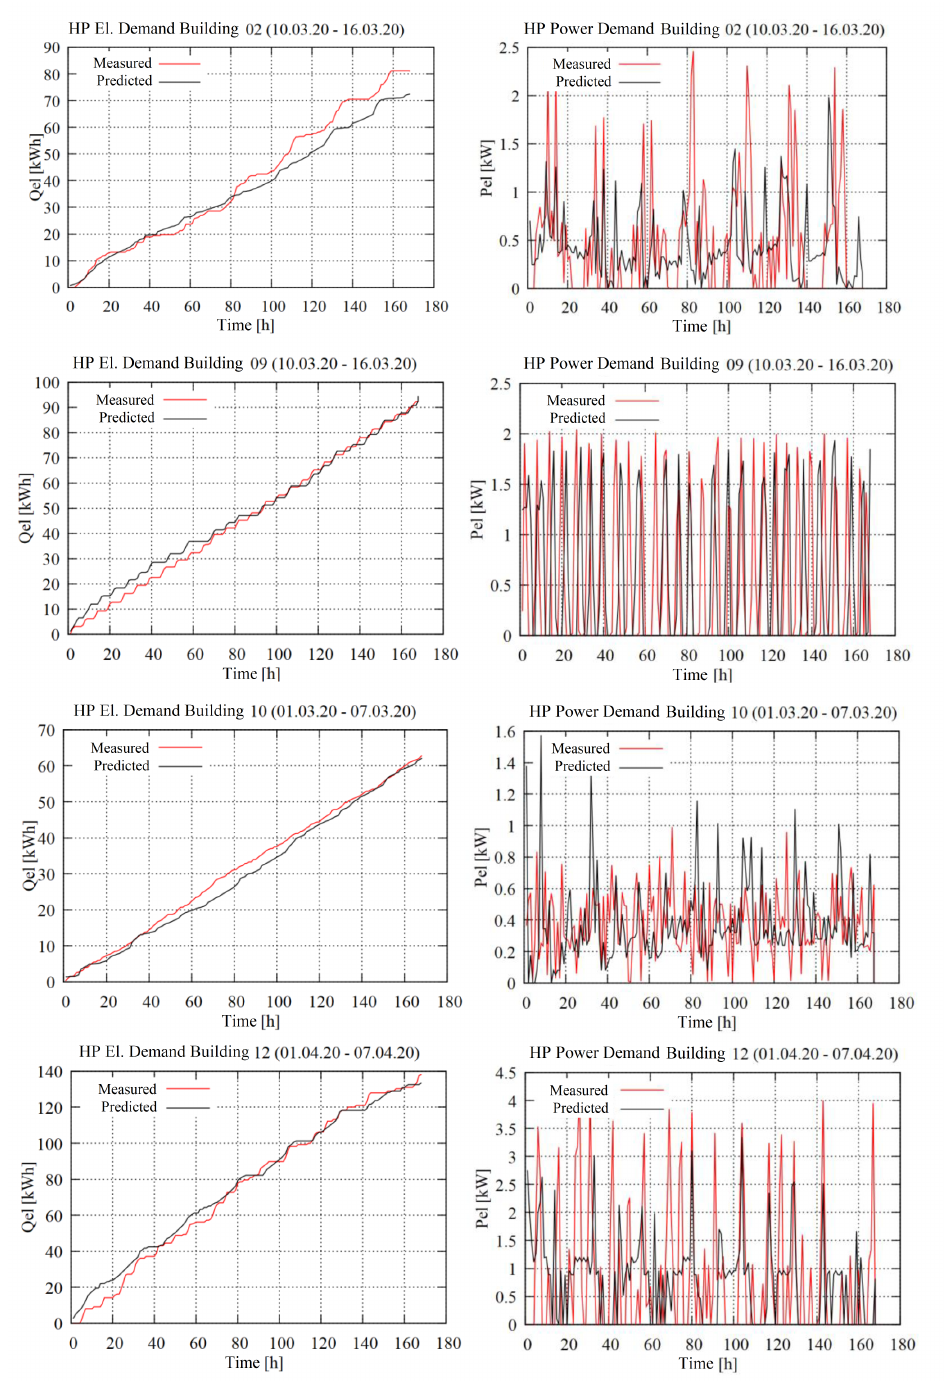
Figure A1. Building model calibration results (Building